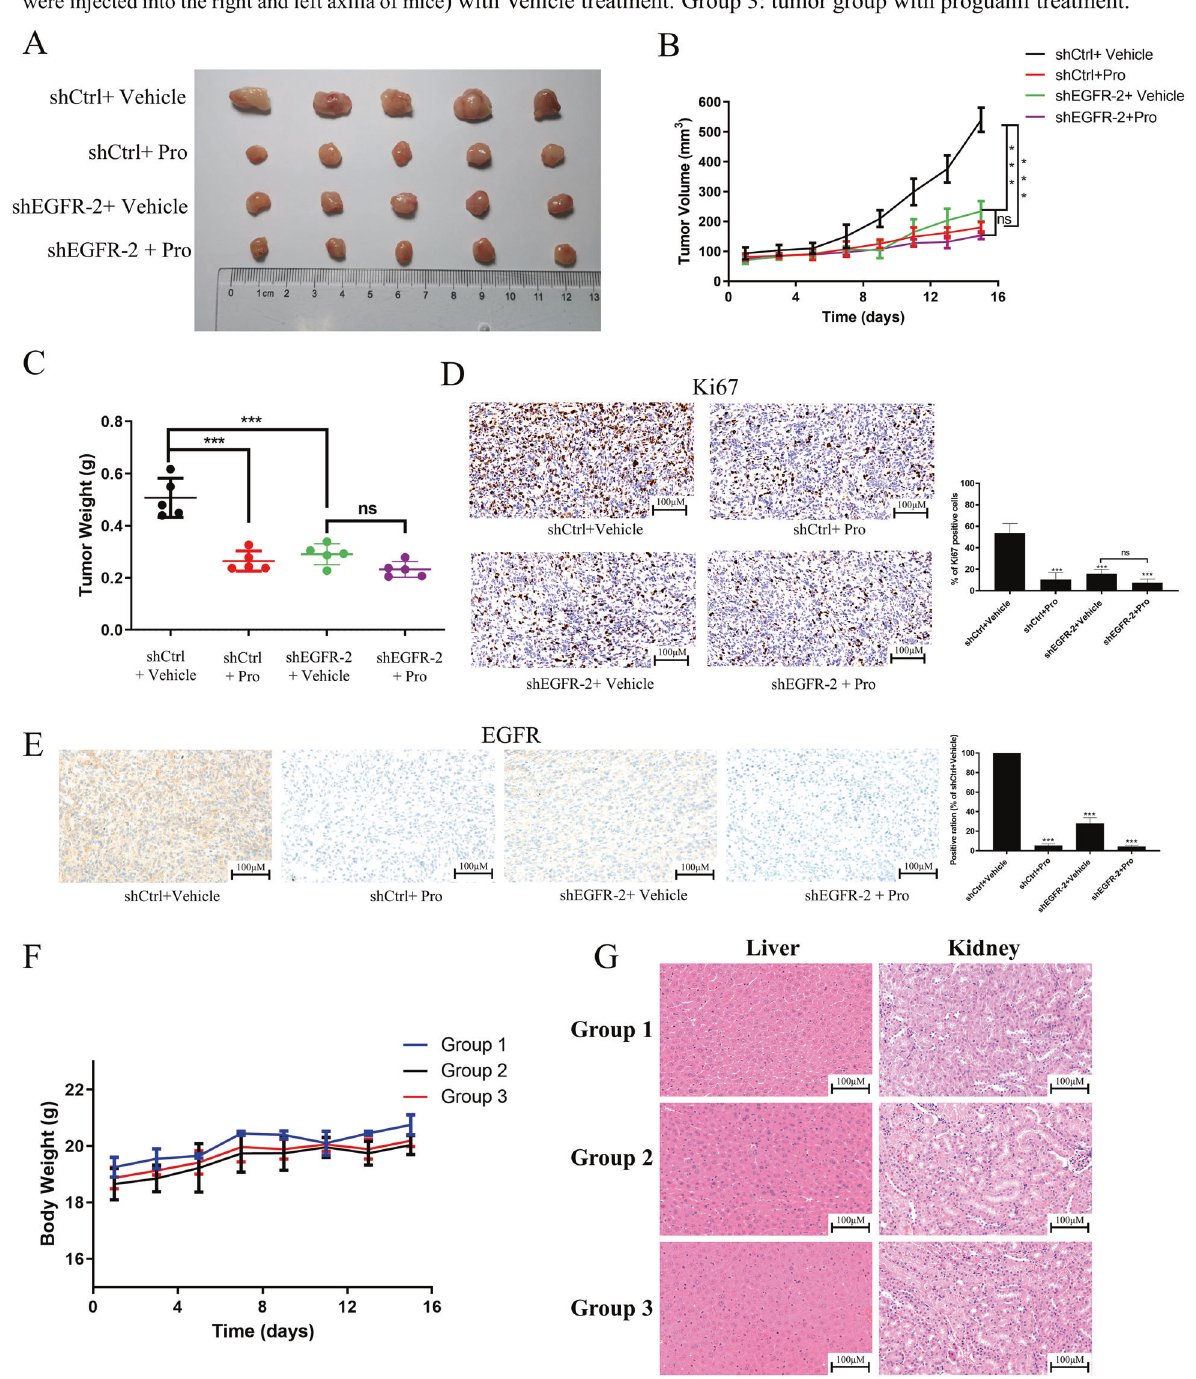
Fig. 8 Proguanil-enhanced EGFR degradation to inhibit the growth of xenograft tumor in vivo. A 10 7 T24 and shEGFR-2 T24 cell suspension were injected into the right and left axilla of mice in group 2 and group 3. When the tumor volume reached 70 – 100 mm 3 , mice in group 3 were treated with proguanil. After treated 14 days, tumors were removed and photographed. B The tumor volume of each mouse was measured every two days, and the mean volume of each group tumor was calculated to create the fi gure. C Statistical analysis of tumor weight. D Ki-67 was used to analyze the proliferation of xenograft tumor. E The expression of EGFR in tumor tissues was detected by immunohistochemistry. F Changes of each group mice weight. G HE staining of liver and kidney organs of each group mice. All in vitro experiments are representative of three independent experiments. Error bars represent means ± SD. Vehicle control(2% PEG-400 + 2% Tween- 80 + 96% PBS). (* P < 0.05, ** P < 0.01, *** P < 0.001, ns not signi fi cant).